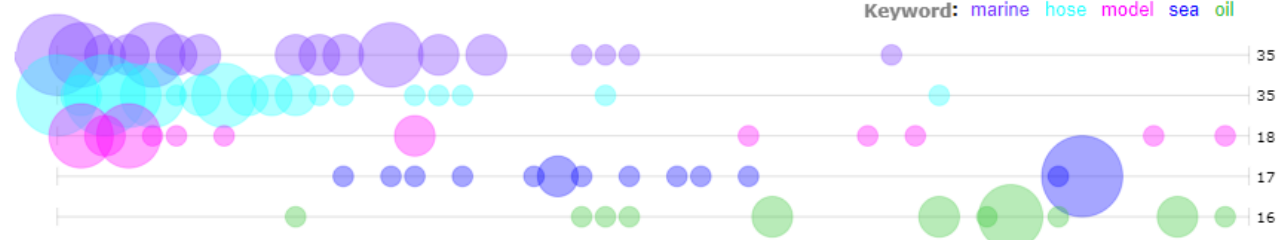
Figure 8. Bubblelines from the most frequent author keywords on “marine hose” generated using Voyant tools.